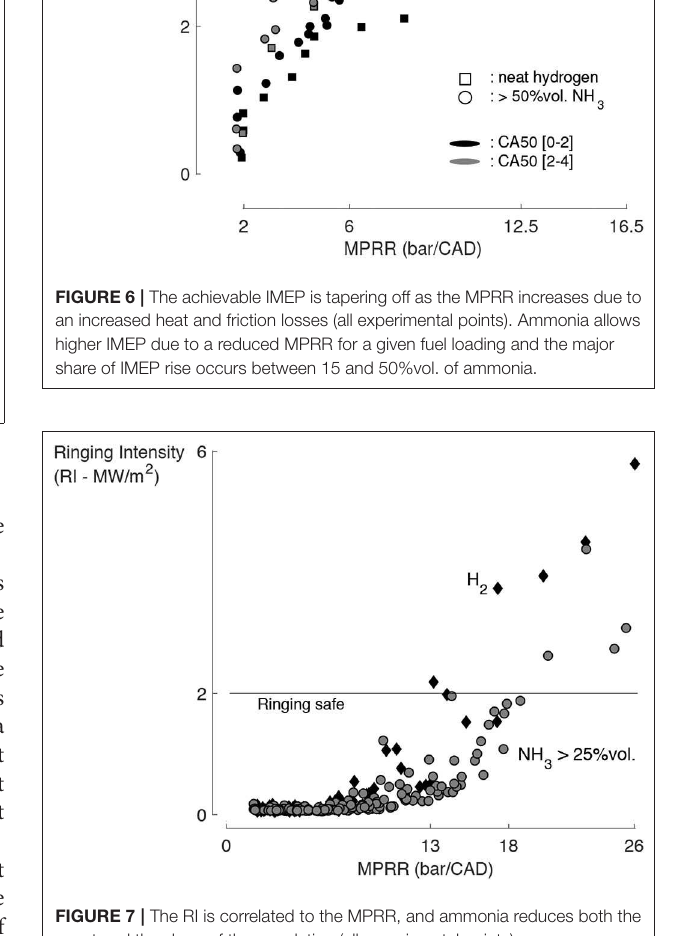
Figure 8 . The set #1 is operated with fixed intake temperature and equivalence ratio (and therefore FuelMEP since ammonia and hydrogen have similar fuel-air mixture energy content). This delay arises both from ammonia slower kinetics and from its higher heat capacity leading to lower T − 15 and P − 15